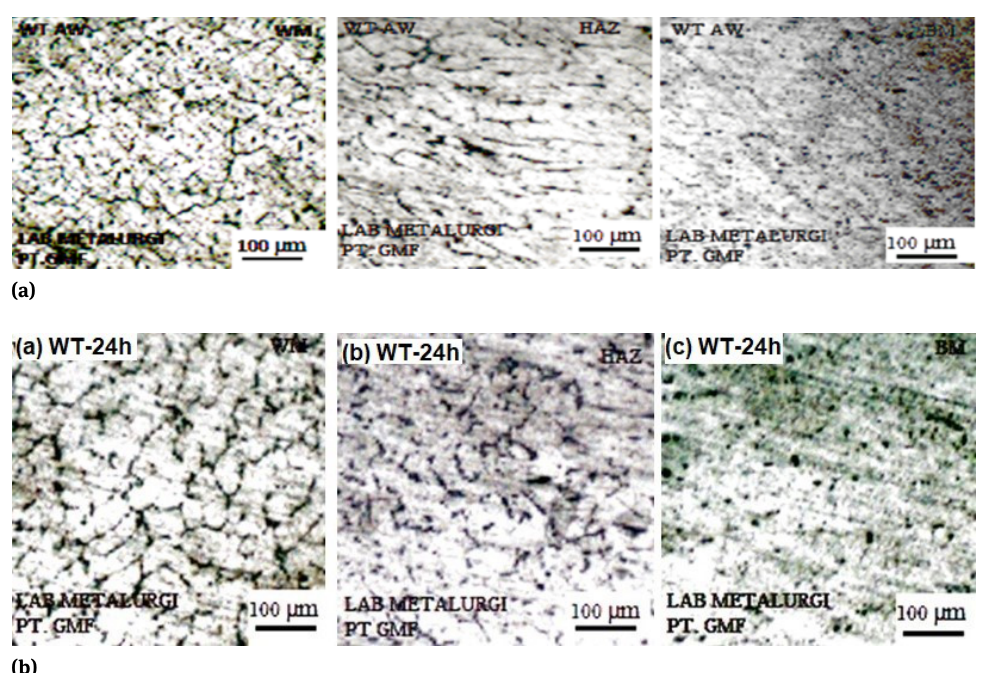
Figure 6: OM images as a comparison of; (a) As-welded AL6061, and (b) AL6061-T6 aged for 24 hours on transversal welding orientation for WM, HAZ, and BM (left to